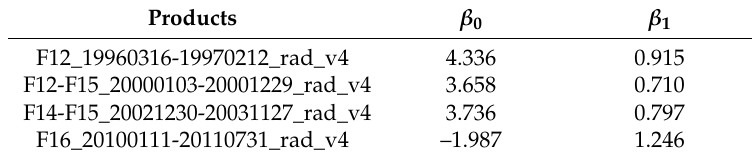
Table 3. Inter-annual calibration coefficients of the global radiance calibrated nighttime light data.